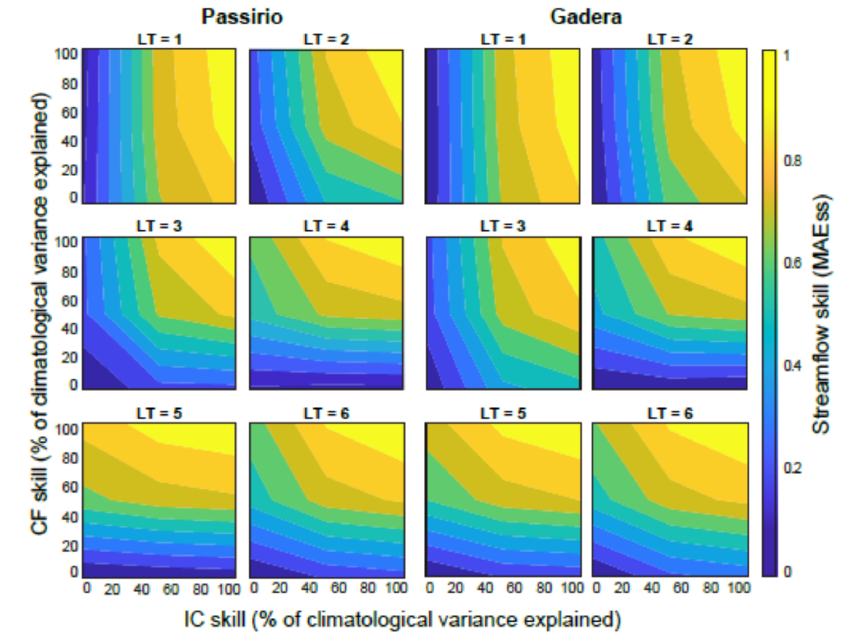
Figure 6. Plots of the mean absolute error skill score (MAEss) for the two case studies, for hindcasts generated over the period 2002–2018 and forecast initialization on 1 December , versus the skill in the two predictability sources (IC, CF). The results are presented for a LT of 1 to 6 months.